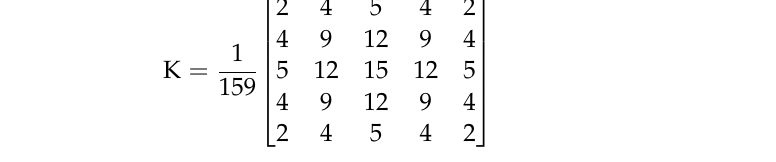
the road surface to detect the lane [30].